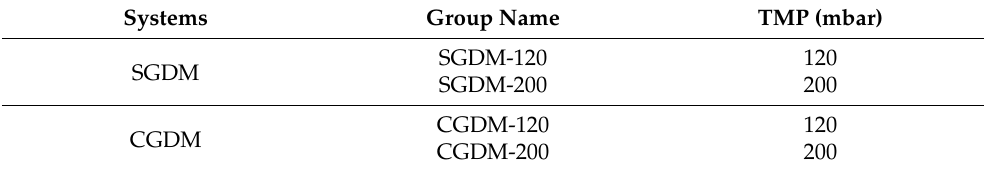
Table 2. Comparison of SGDM and CGDM systems